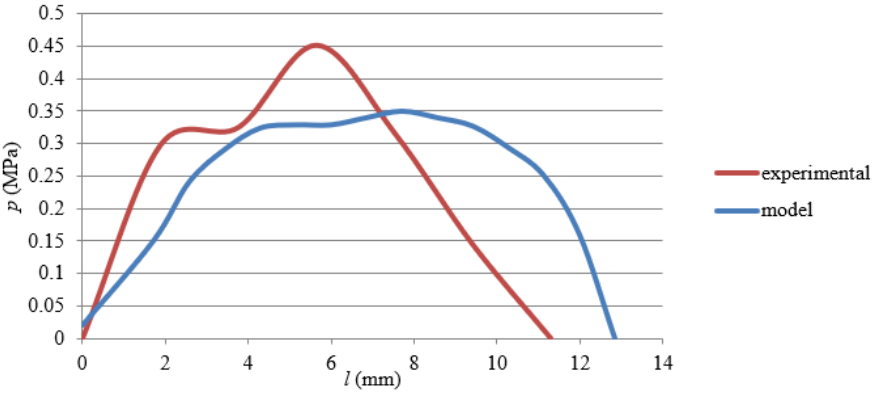
Figure 12. Surface pressure values as a function of the distance for dropping an apple from a height of 10 mm.